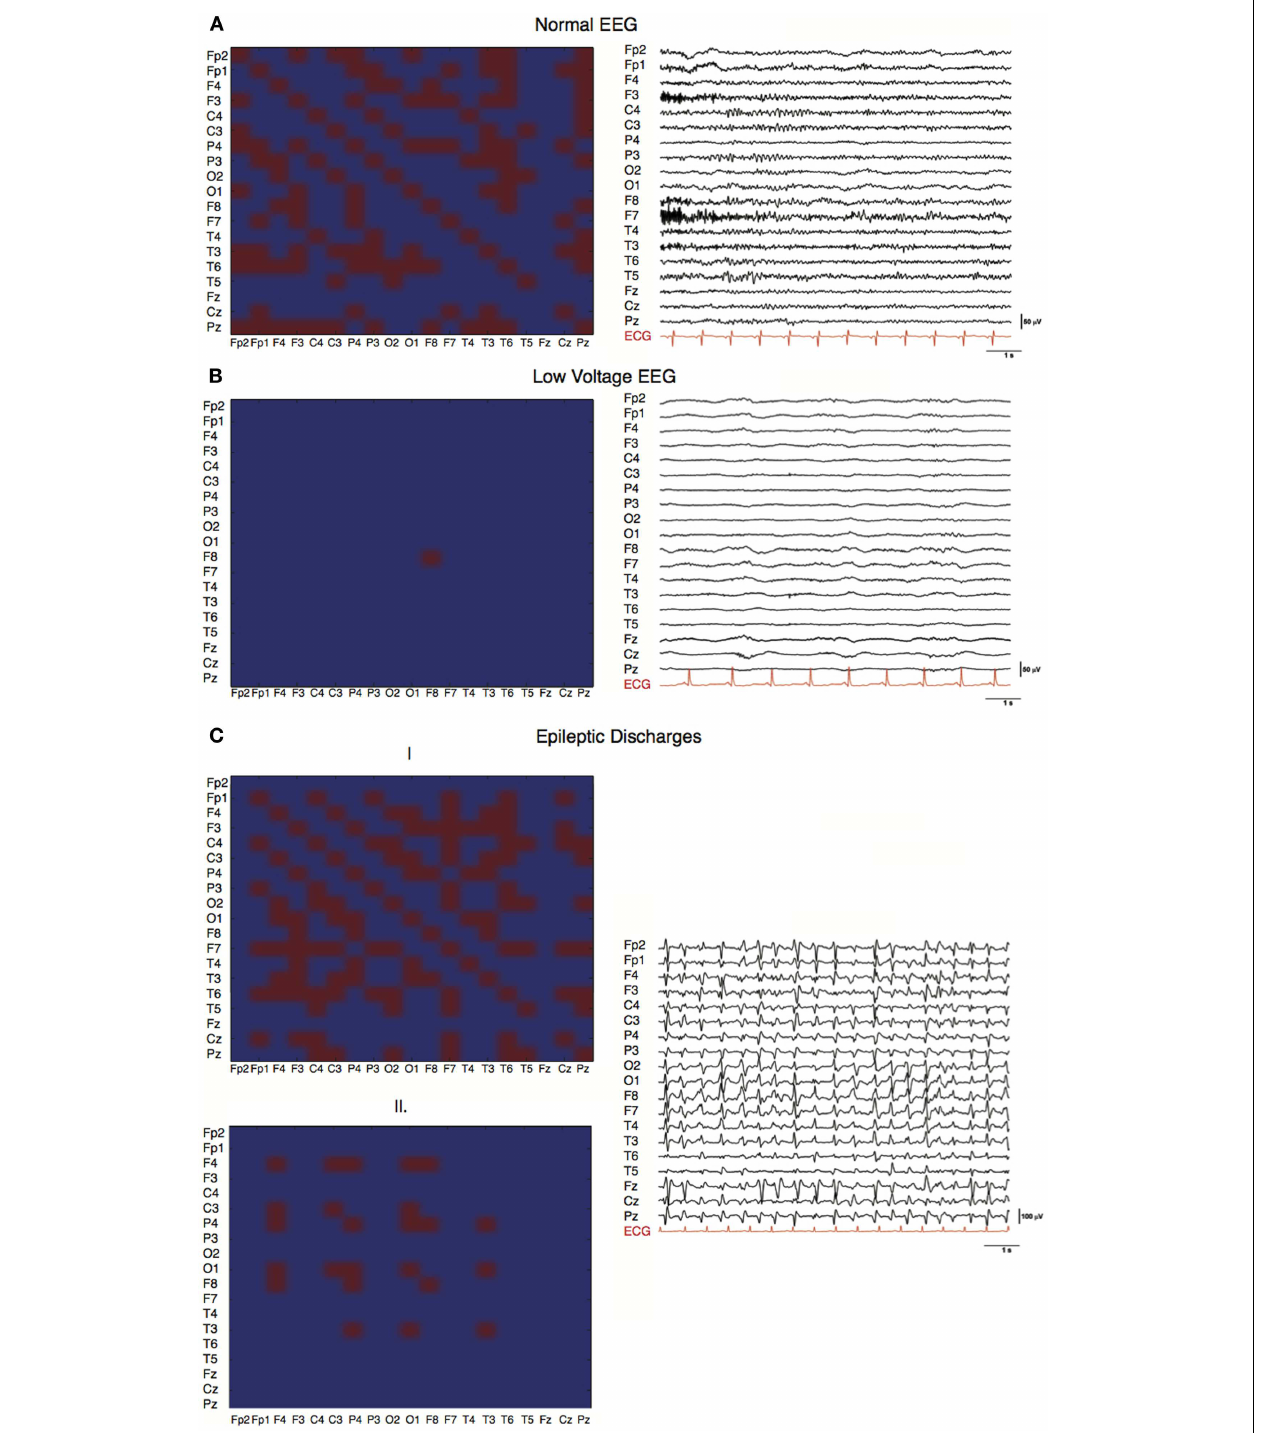
matrix of a PAE patient with a low-voltage EEG pattern ( C = 0, L = 1, SWI = 0). Only one electrode had sufficient power to produce a detectable EEG wave. No network was present. (C) Adjacency matrices of a PAE patient showing generalized epileptic discharges with varying network size and number of connections within a 5-min epoch, (1) C = 0.32, L = 1.33, SWI = 0.24; (2) C = 0.86, L = 1.76, SWI =